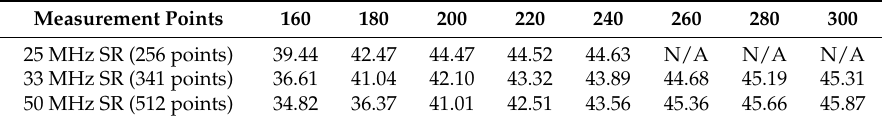
Table 4. Comparative PSNR of different SRs when keeping the same sampling points, using experiment data.